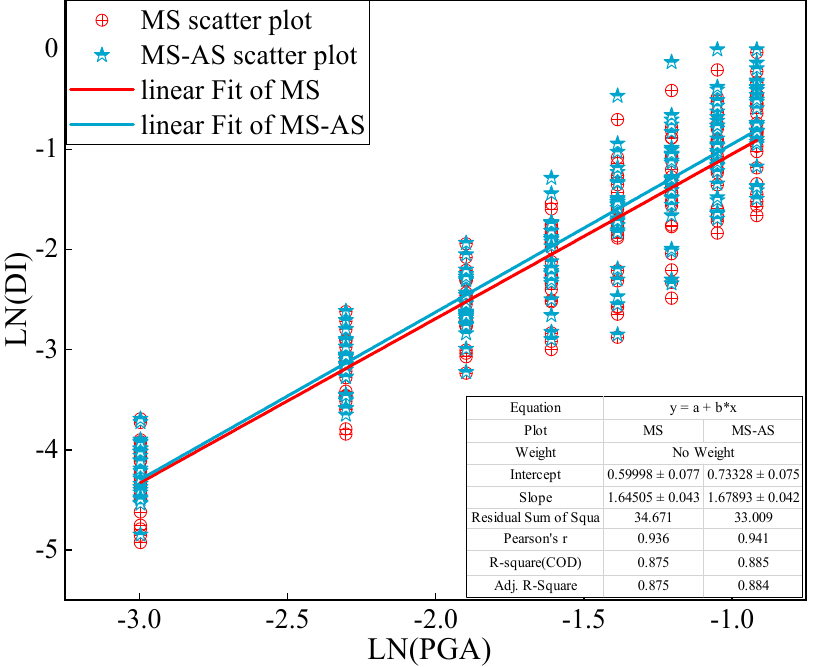
Figure 9. Scatter diagram of the column under MS-AS. Table 6. Linear fitting equation of the